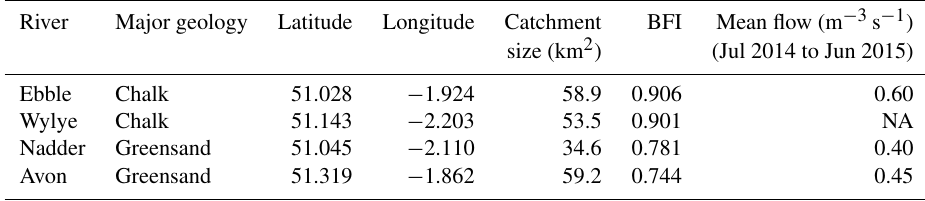
Table 1. Site location and catchment characteristics.